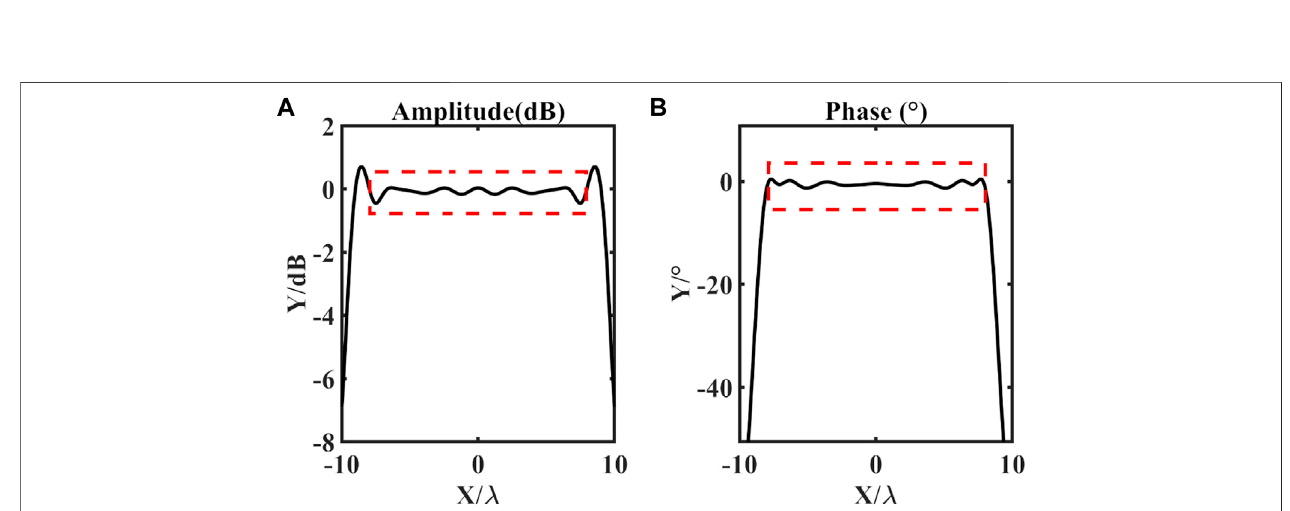
FIGURE 6 | Cross-sectional (A) Amplitude error (B) Phase